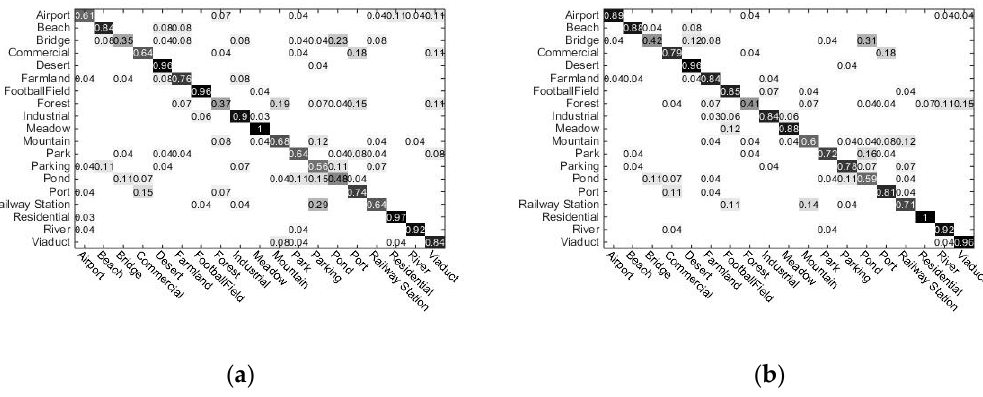
Figure 8. Confusion matrices based on LBP. ( a ) Traditional LLC ( LBP ); ( b ) Proposed method ( LBP ).